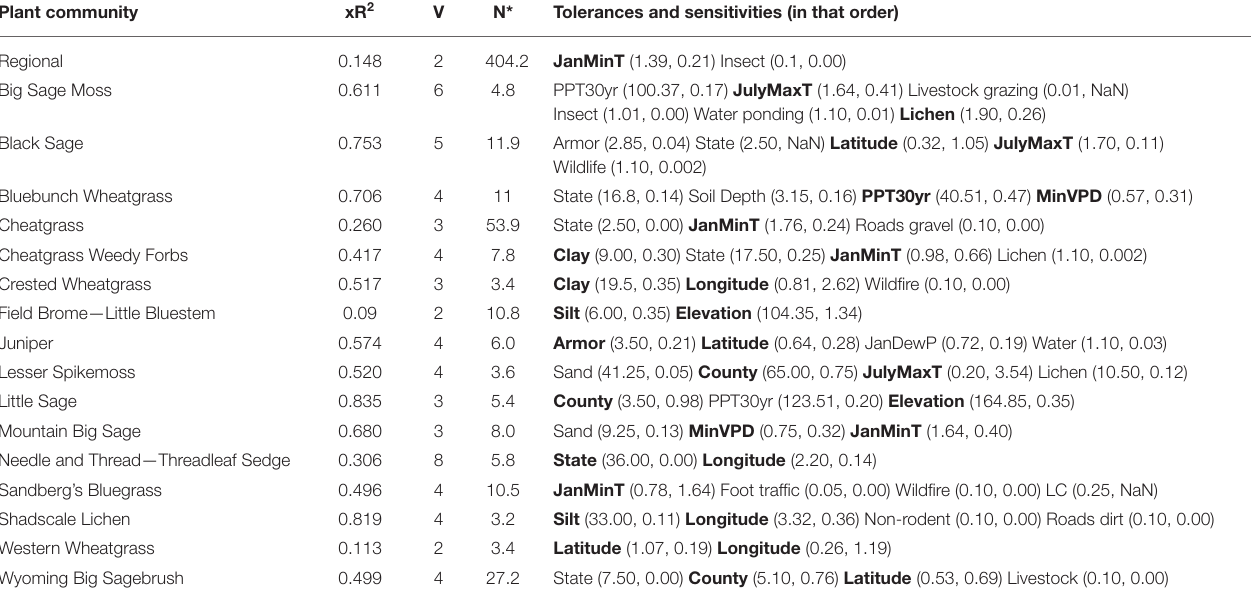
TABLE 2 | Best NPMR models for moss cover by plant community. Plant